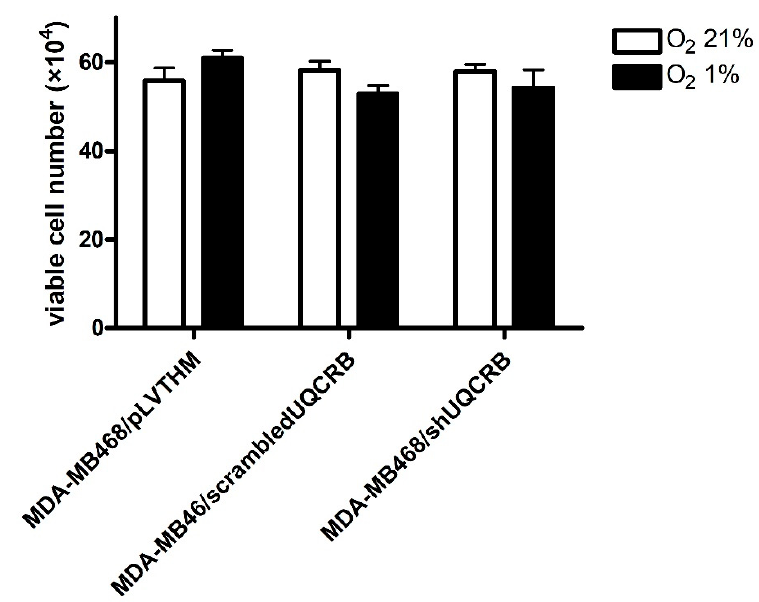
Figure 7. Effects of UQCRB silencing on MDA-MB468/pLVTHM, MDA-MB468/scrambledUQCRB, and MDA-MB468/shUQCRB cell viability in normoxia (O 2 21%) or hypoxia (O 2 1%) (mean ± S.E. of 3 independent experiments).